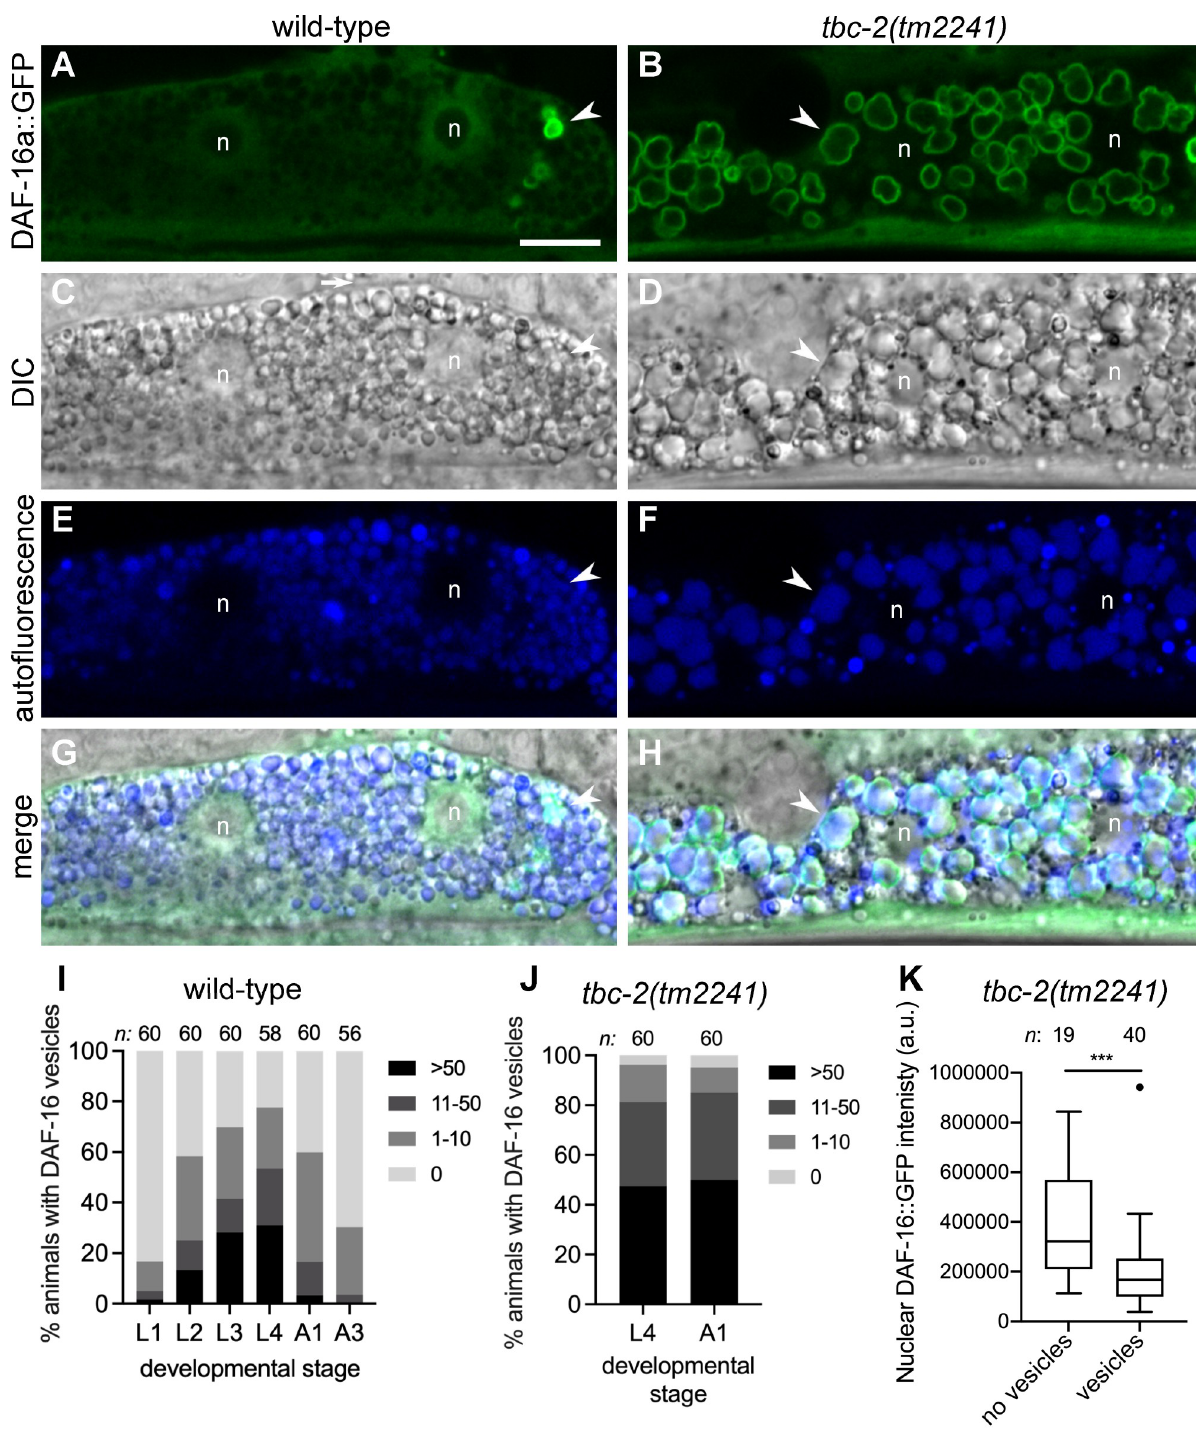
Fig 1. DAF-16 FOXO localizes to vesicles in intestinal cells. (A-H) Representative confocal and differential interference contrast (DIC) images of an intestinal cell of wild-type (A, C, E, G) and tbc-2(tm2241) (B, D, F, H) animals expressing DAF-16a::GFP (zIs356) . DAF-16a::GFP (green) is present on vesicles in both wild-type and tbc-2(tm2241) intestinal cells (A and B) that are positive for autofluorescence (blue) present in the the endolysosomal system (E and F). Corresponding DIC (C and D) and merged (G and H) images are shown. A representative vesicle is shown (arrow head) and the two nuclei of the binucleate cell are marked (n). Note that DAF-16a::GFP is excluded from the large nucleoli (A). (I-J) Grouped bar graphs quantifying the percentage of wild-type (I) and tbc-2(tm2241) (J) animals with 0, 1–10, 11–50 or > 50 DAF-16a::GFP (zIs356) positive vesicles at the different larval